Question: Sum up the contents of this chart in one sentence.
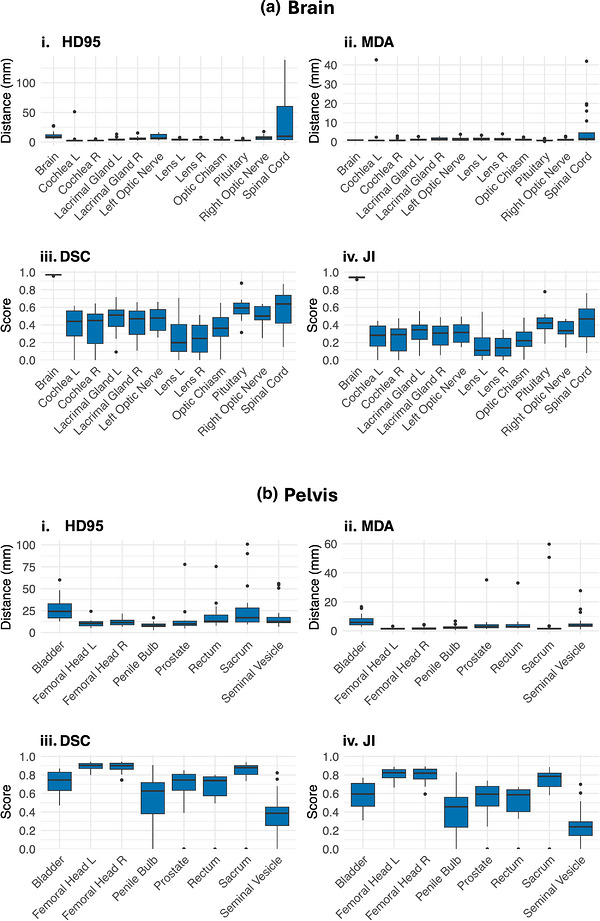
Answer: Segmentation metrics across contours and patients for (a) brain and (b) pelvic scans. The (i) Hausdorff Distance (HD95), (ii) Mean Distance to Agreement (MDA), (iii) Dice Similarity Coefficient (DSC), and (iv) Jaccard Index (JI) were calculated between CPAI‐generated contours for the sCT and the CT.